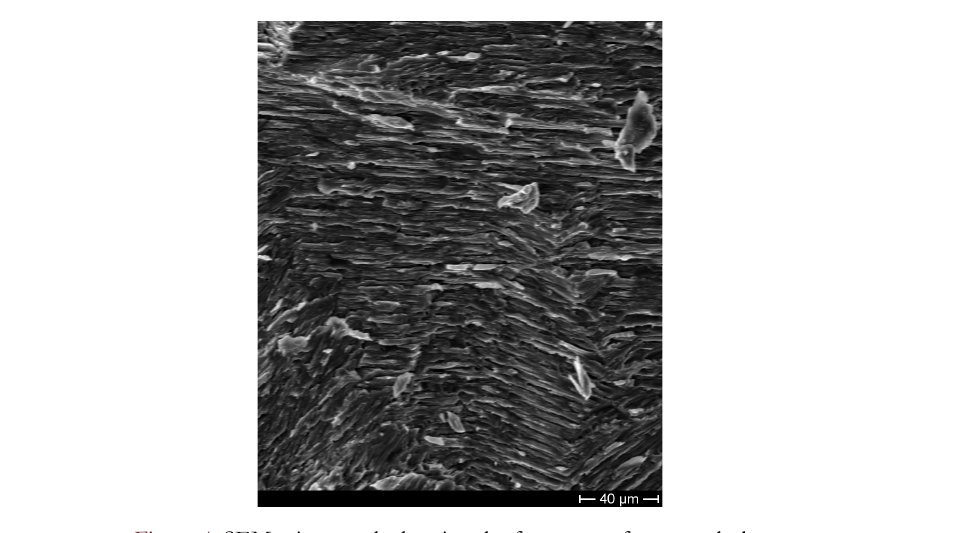
Figure 4: SEM micrograph showing the fracture surface morphology.